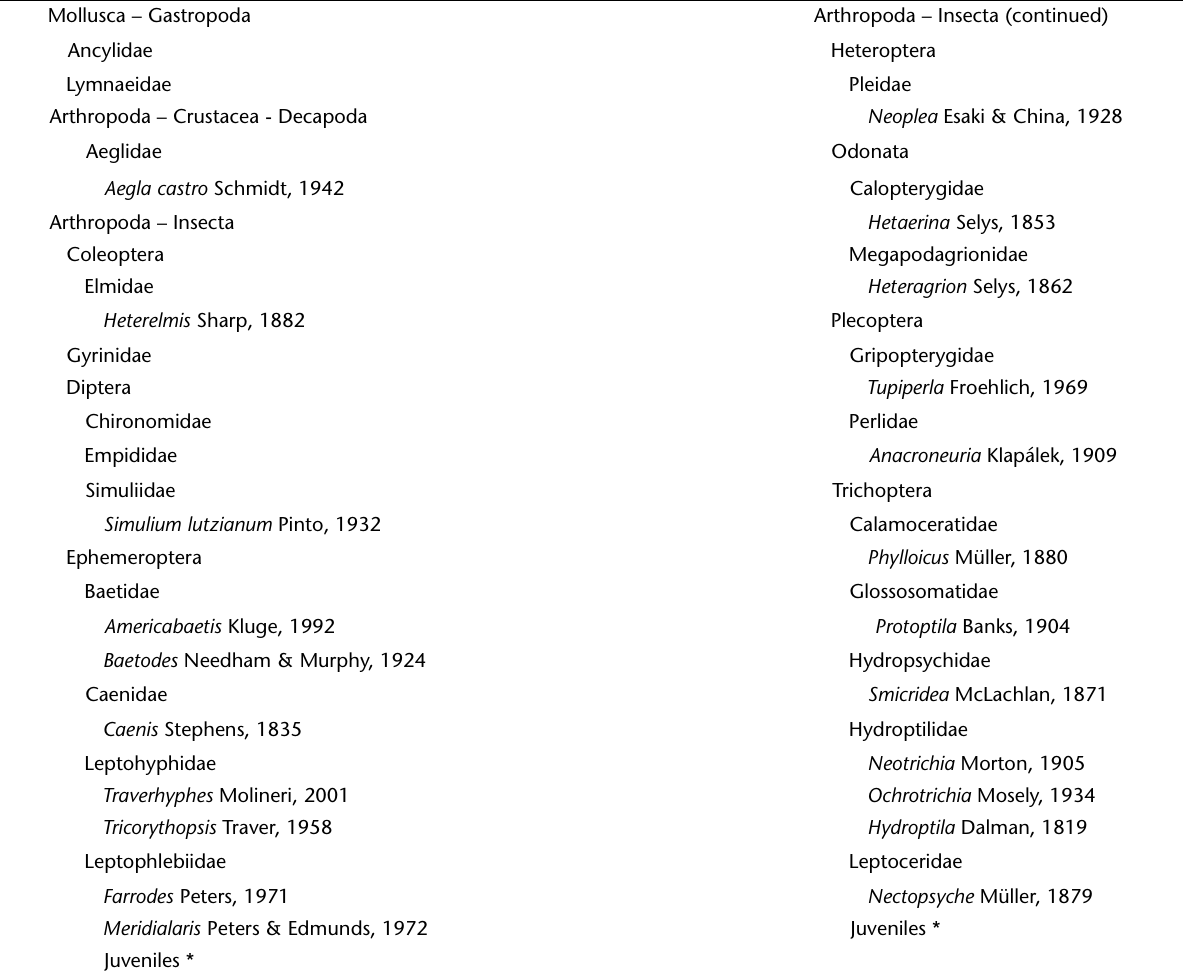
Table I. Macroinvertebrates sampled in leaf-bags incubated in the Ribeirão da Quinta stream, during the dry (July 2004) and rainy (December 2004)